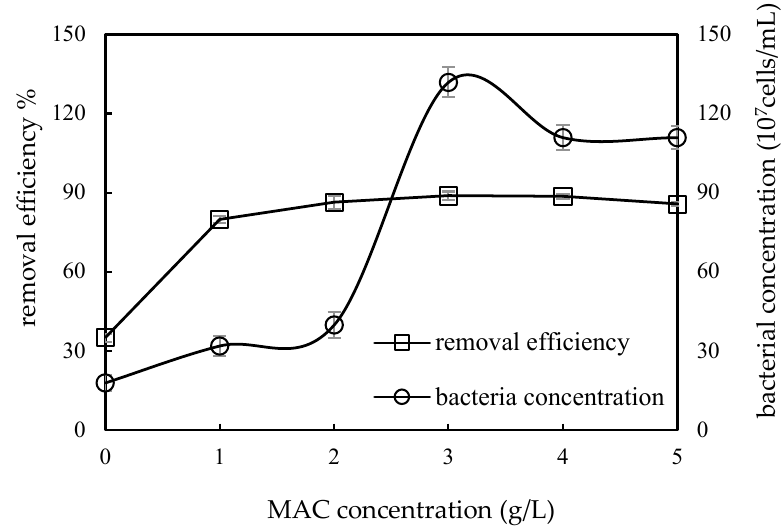
Figure 3. Effects of added MAC concentrations on the removal efficiency of diesel oil and the activity of bacteria (experimental conditions: MAC mass: 0–3 g/L; solution volume: 100 mL; temperature: 30 °C; pH = 7; time: 15 days; rotating speed: 150 r/min).